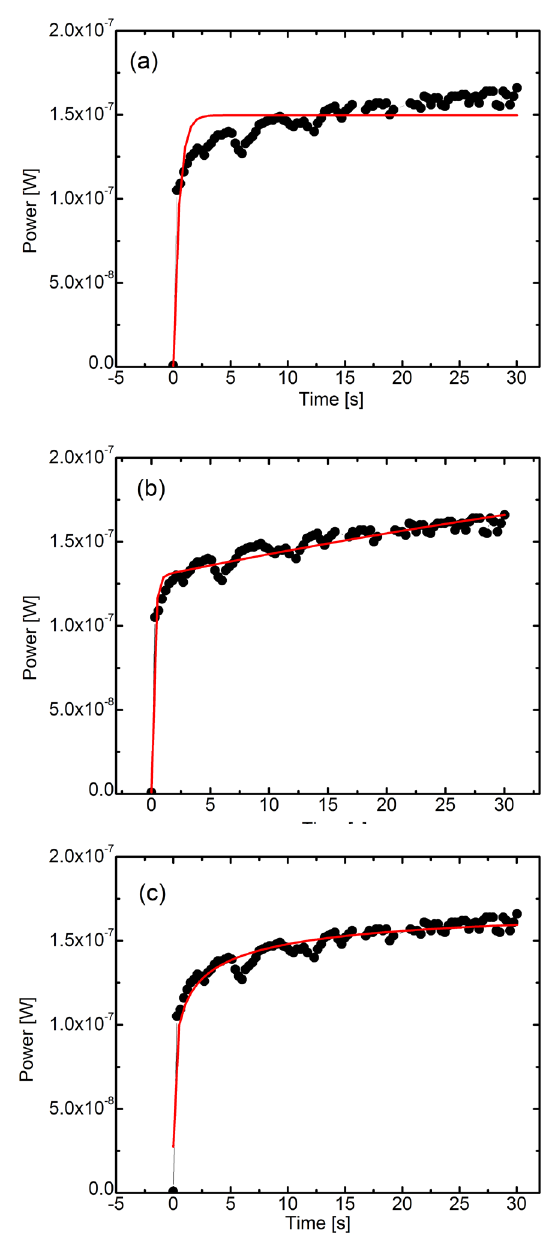
Figure 3. Time evolution of measured intensity for DR1:DNA-CTMA system in a long time interval. Fits: single exponential (a), bi–exponential (b), stretched exponential (c). Fig. 5 (left). It assumes that each DR1 molecule which has undergone the photo-isomerization cycle trans-cis- trans preserves the memory about its initial orientation in the space and returns exactly to this orientation.